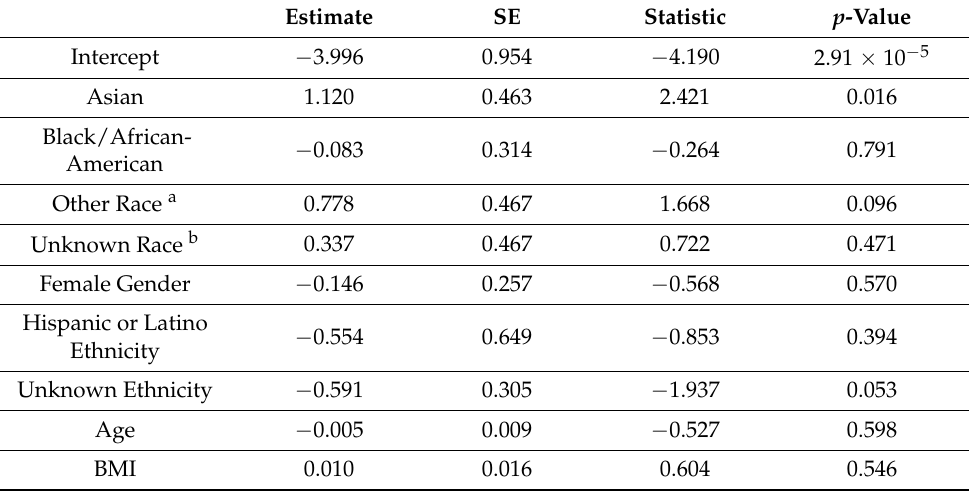
Table 3. Logistic regression model for hemorrhage associated with warfarin use relative to White/European-American patients #